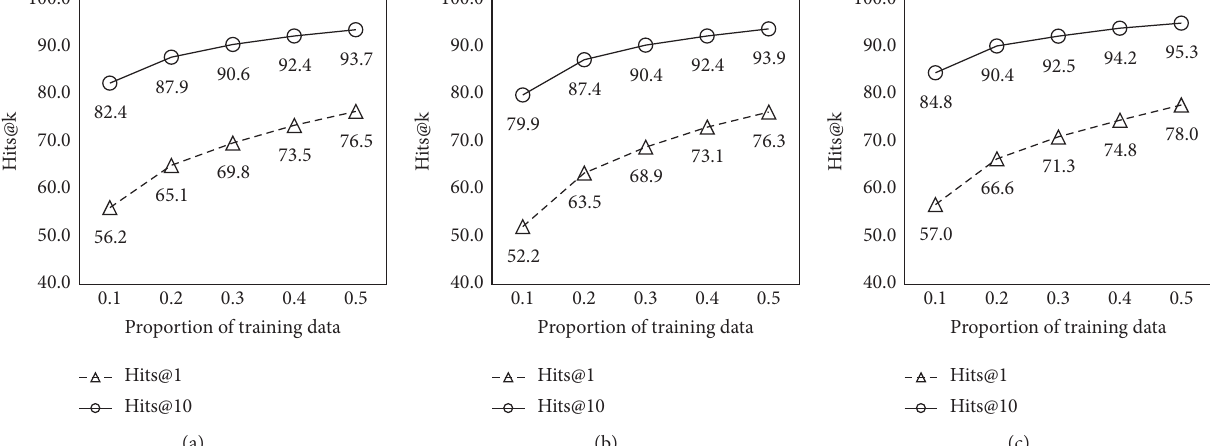
Figure 6. The performances become steady when c ≥ 2 with at most 2.5% range from all datasets. Therefore, CAREA can keep stable when c varies within a rea- sonable range.